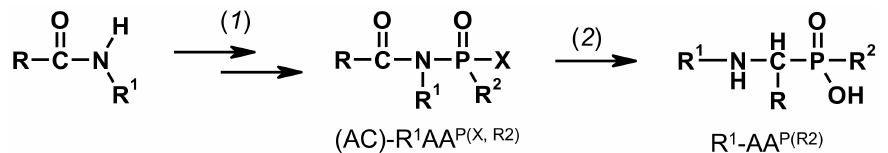
Figure 2. Scheme of Engelmann-Pikl-Oleksyszyn methods for synthesis of secondary 1-aminoalkylphosphonic (R 2 =OH) and 1-aminoalkylphosphinic (R 2 =H, alkyl) acids ( 1 ) aldehyde, R-PCl 2 /AcOH; and ( 2 ) 5M HCl-H 2 O, ∆ 8–10